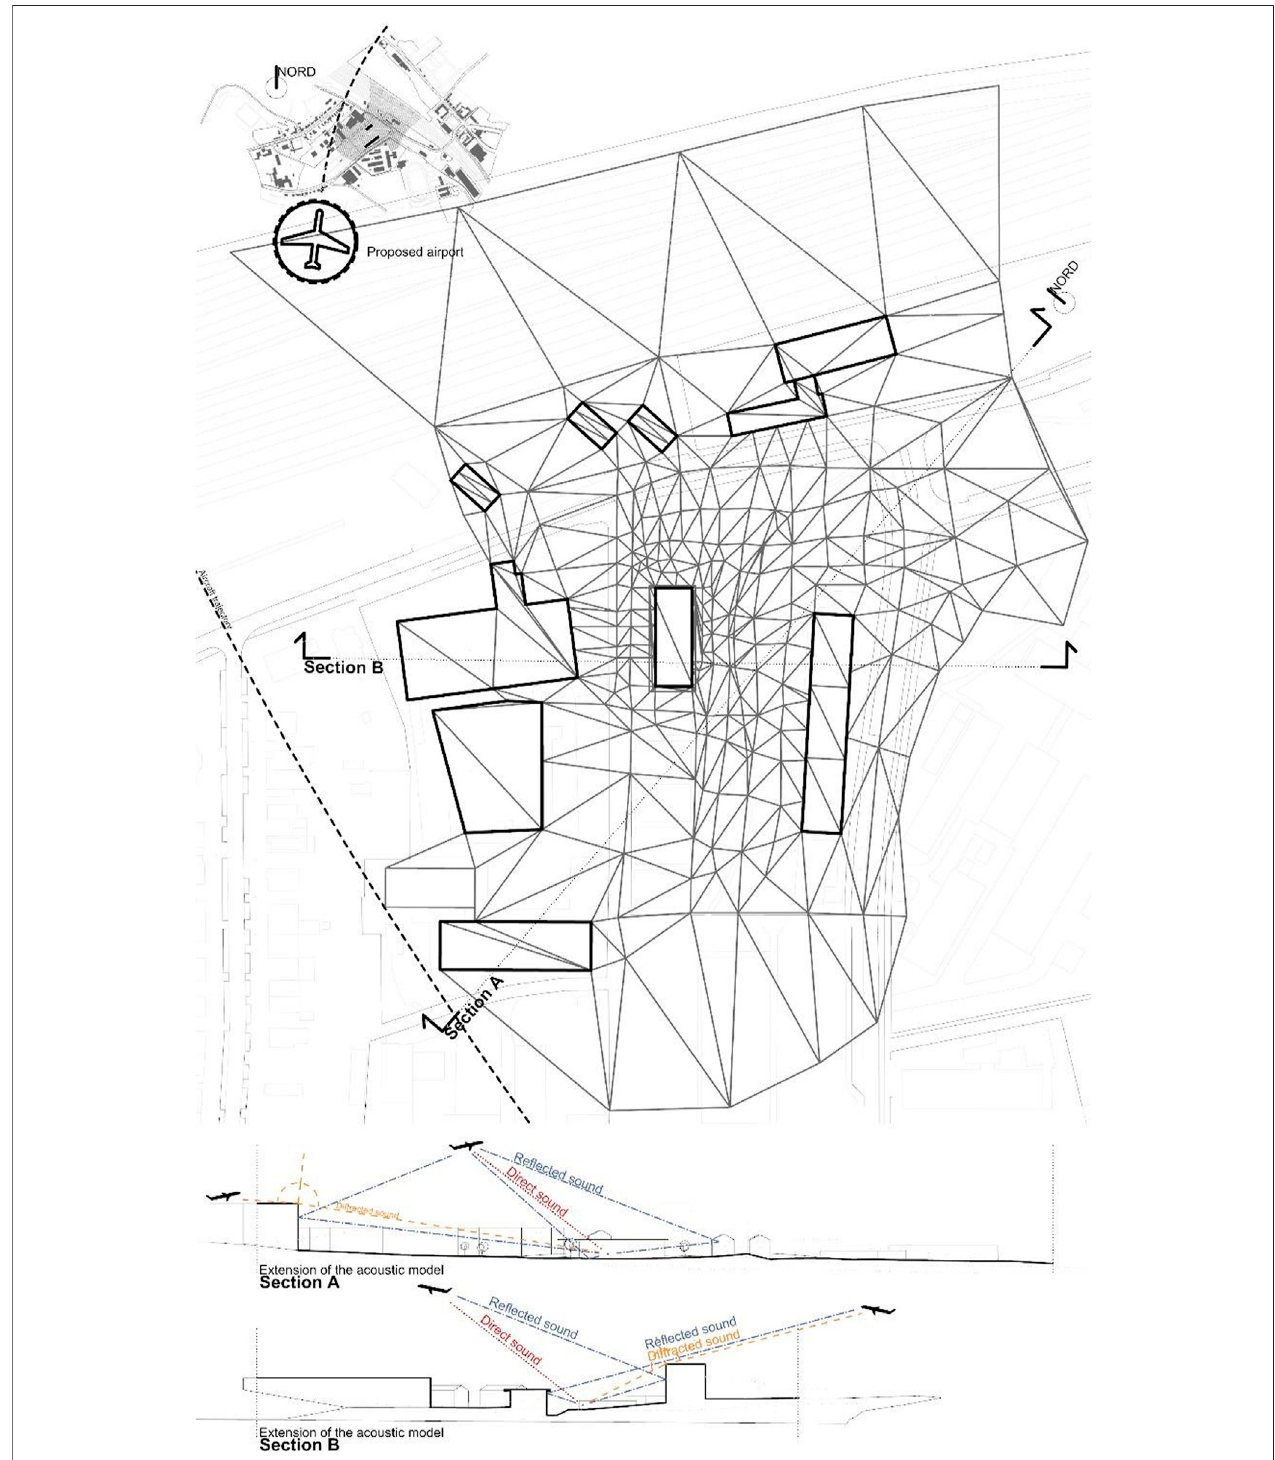
FIGURE 6 | Geometric de fi nition for the acoustic model of Demonstrator A: (A) a local view with an aircraft noise source starting from a suggested airport location; (B) mesh de fi nition; (C) two sections of the mesh with modeling criterion based on sound propagation paths.